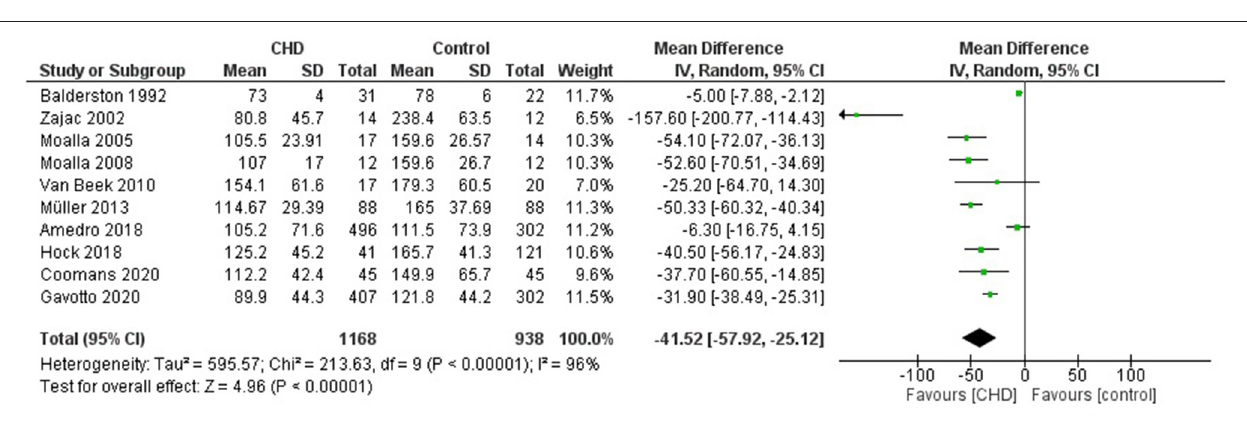
compared 1305 participants with CHD vs. 961 healthy